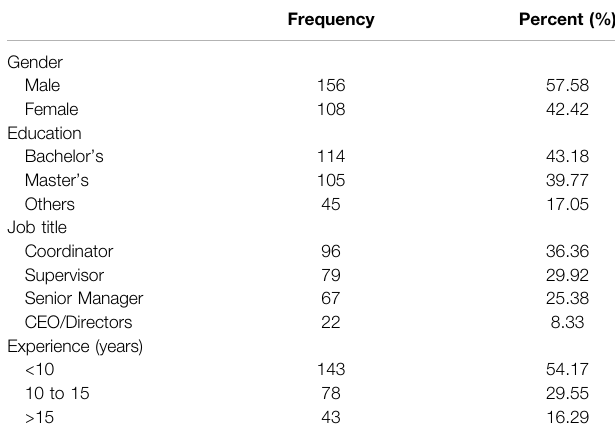
TABLE 1 | Demographic